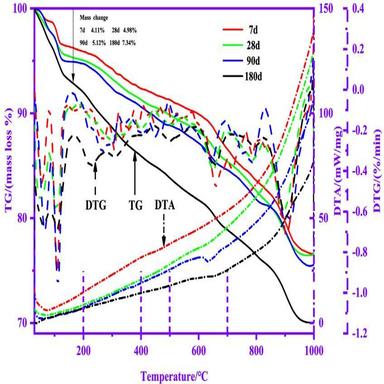
TG pattern of sample RFG-5 with different curing time.